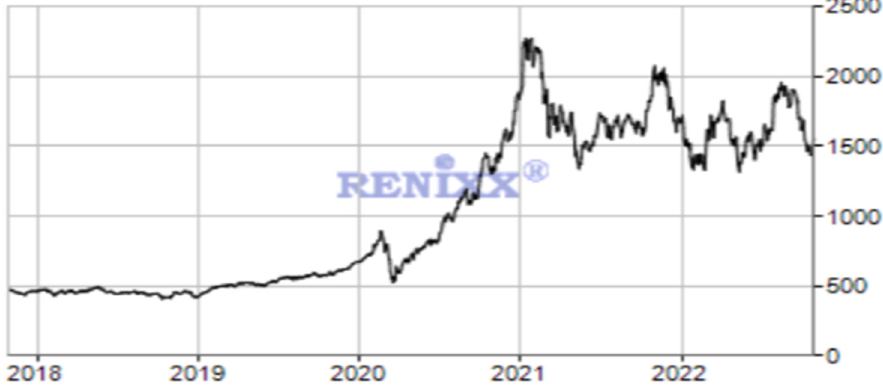
Figure 2. Renewable Energy Industrial Index World: Five-years quotes. Source: [77].